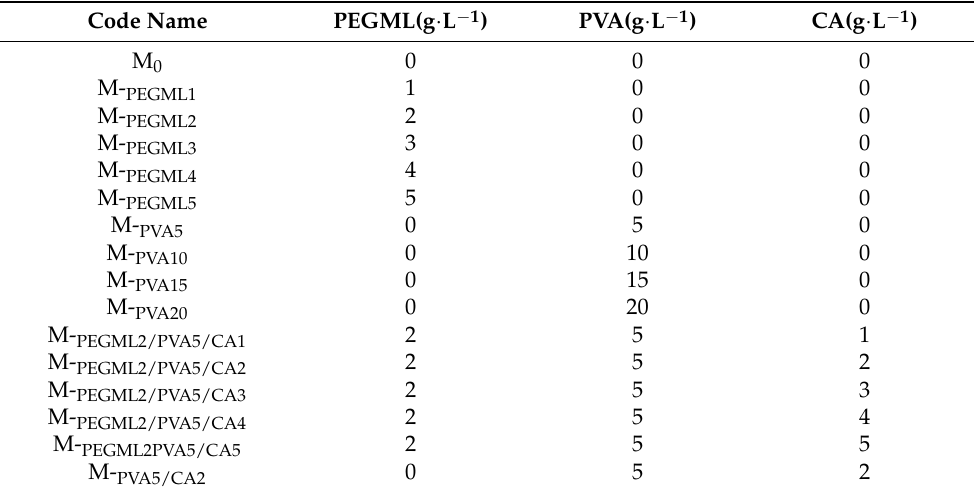
Table 1. Modification conditions of different PTFE microfiltration membranes.